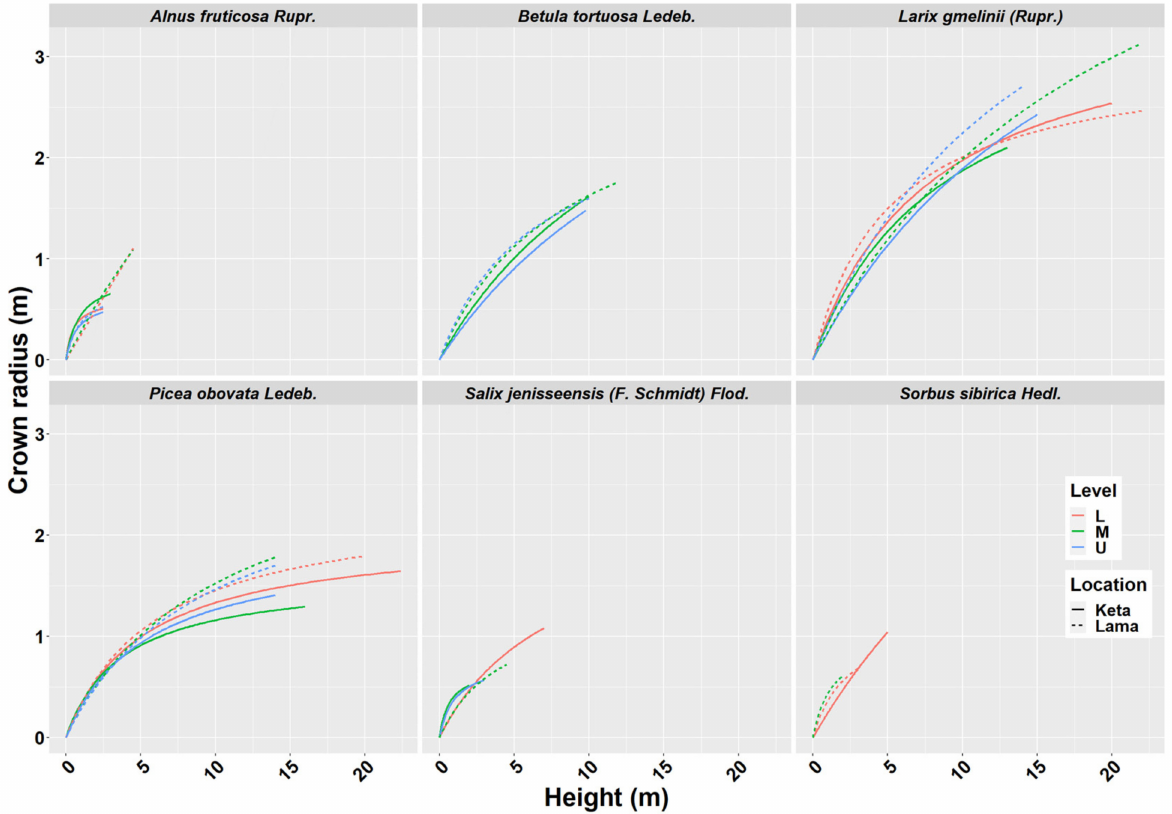
Figure 2. Crown radius—height models of six tree species at two locations of Keta and Lama. Statistical parameters of models are presented in Table 2. Level: L—lower elevational zone, M—middle elevational zone, U—upper elevational